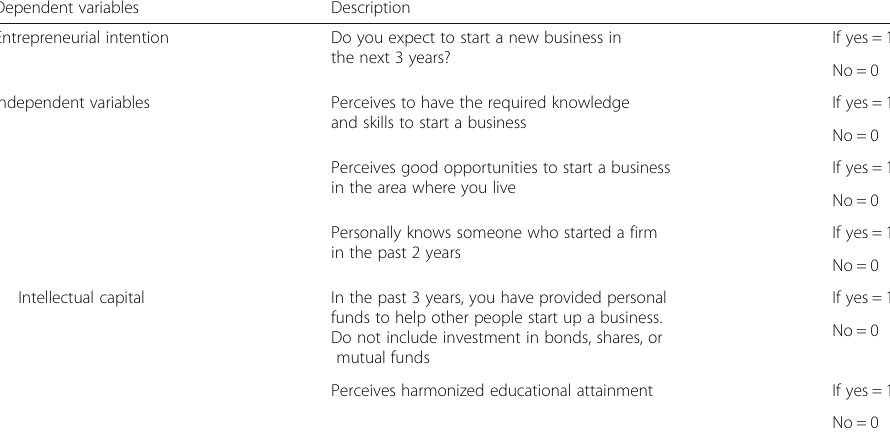
Table 1 Description of